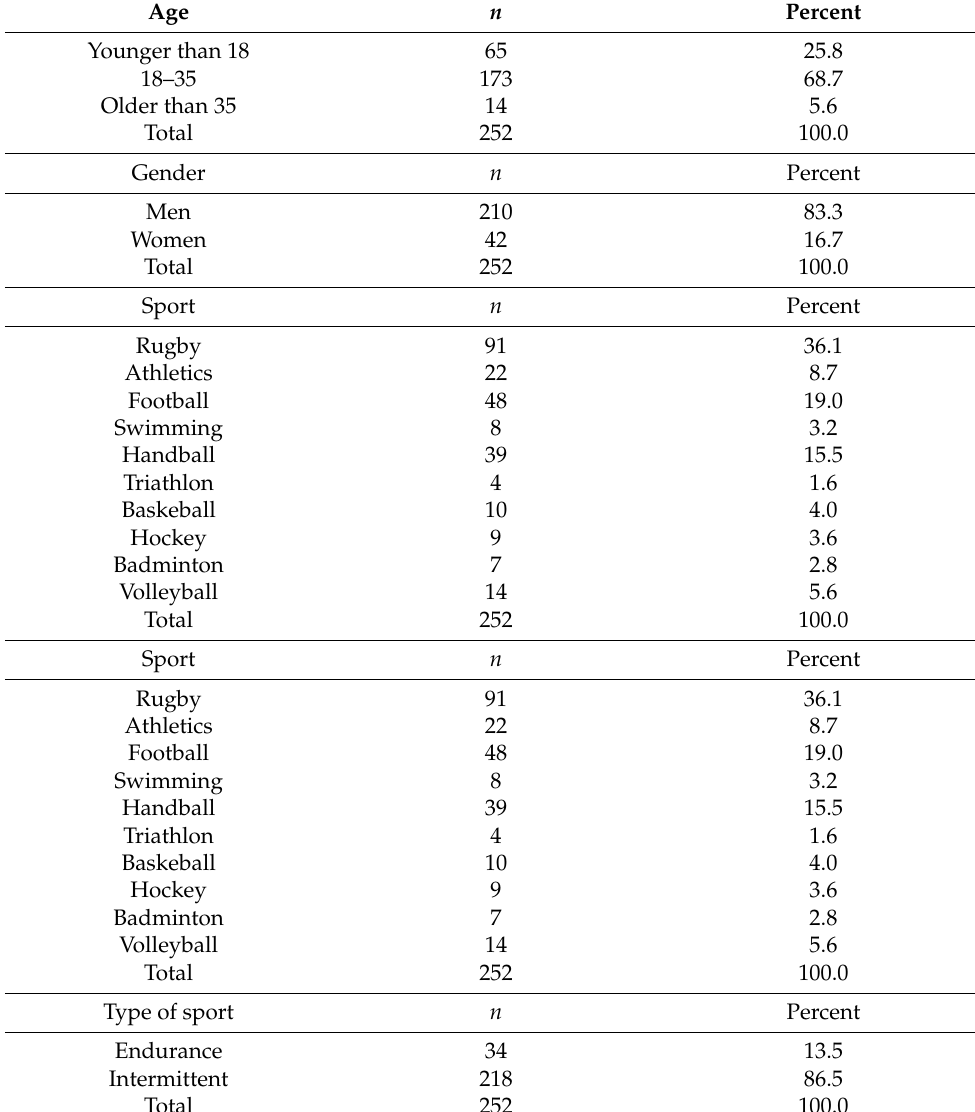
Table 2. Age of participants, gender of participants, sport and type of sport.